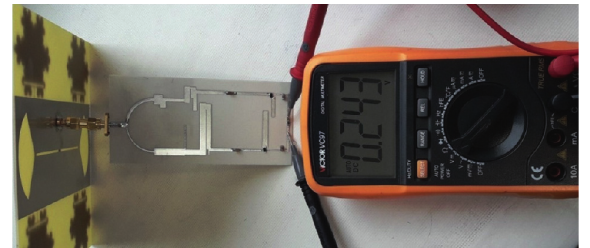
Figure 16: Rectenna measurement in a typical indoor laboratory ambience with a voltage